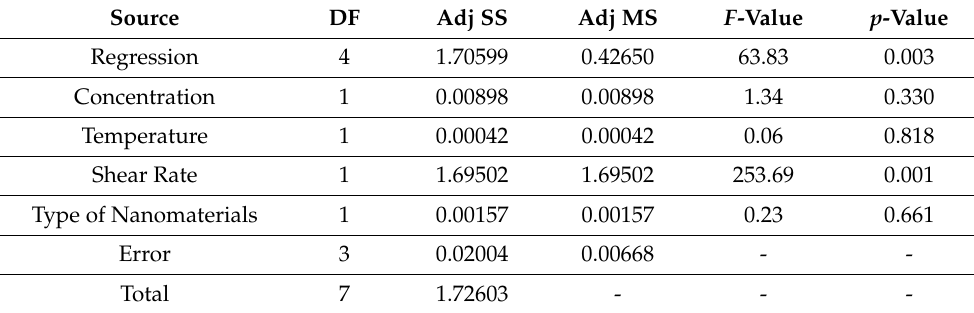
Table 5. Analysis of variance (shear